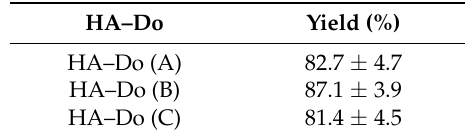
Figure 2. ( a ) Synthetic scheme for hyaluronan-conjugated dodecylamine (HA–Do); ( b ) Fourier- transform infrared (FT-IR) spectra and ( c ) 1 H-NMR spectra of HA–Do (A), HA–Do (B), and HA–Do (C). Table 1. The yield of the HA–Do synthesis Table 1. The yield of the HA–Do synthesis reaction.